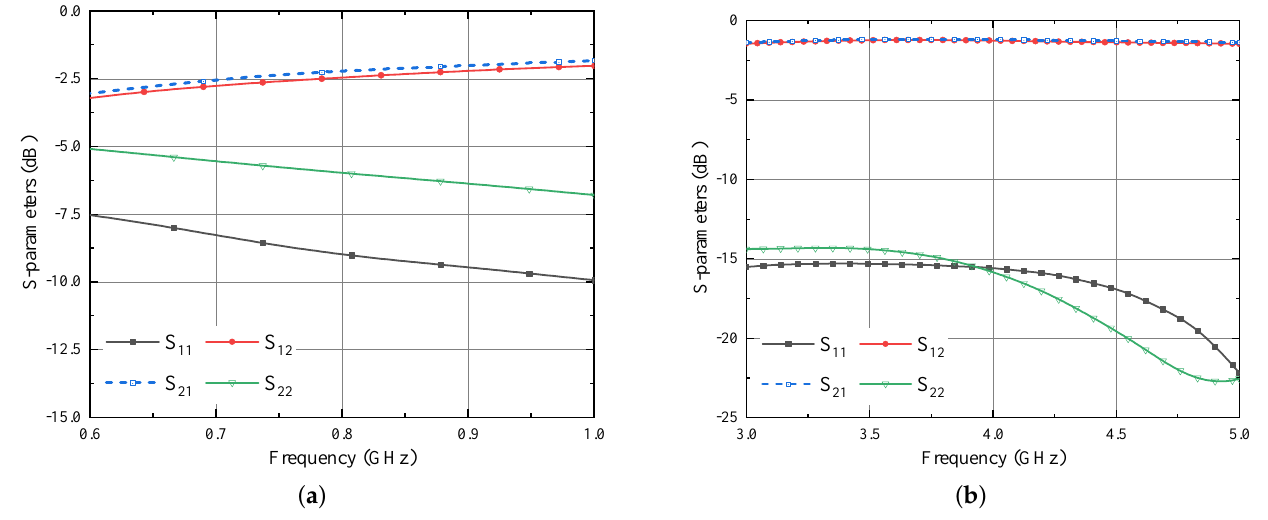
Figure 16. Simulated S-parameter results of planar balun at ( a ) UHF band ( b ) UWB band. The schematic of the balun inserted at the bottom side of Iteration 2 design is sim- ilar to Figure 15. However, due to the large ground plane of the Iteration 2 antenna (140 mm × 140 mm), the value of 50 Ω feed line length ( BL in ) is increased to 52.6 mm. In addition, the ground plane and the substrate size is increased to 140 mm × 140 mm. The simulated results of the antenna integrated with the balun are shown in Figure